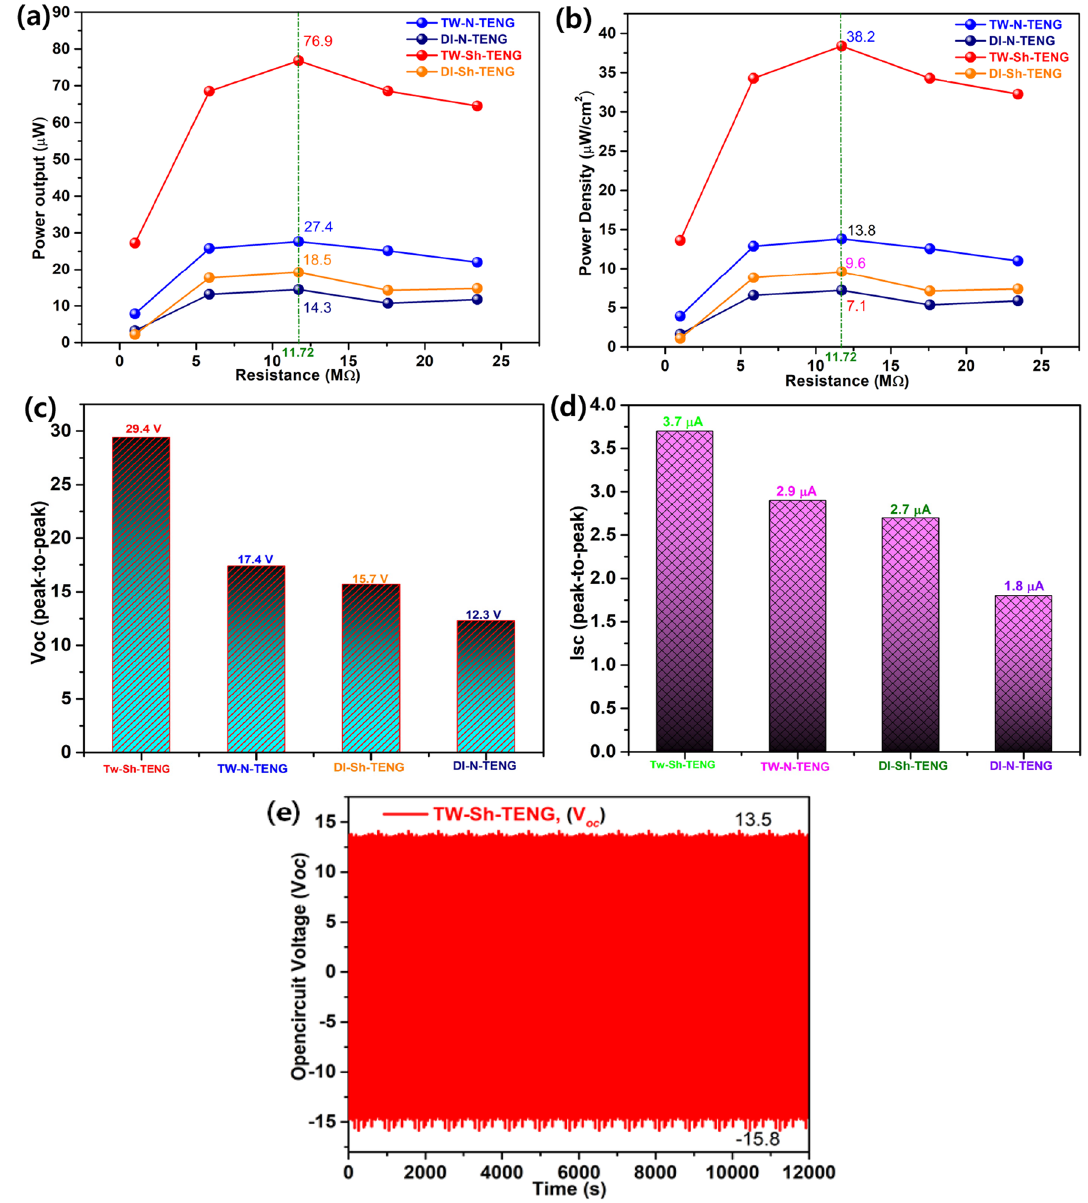
Figure 9. The power output ( a ); power density ( b ) and comparison of overall V oc ( c ) and I sc ( d ) of TW-Sh- TENG, TW-N-PTFE-TENG, DI-Sh-TENG and DI-N-TENG; ( e ) stability and durability test for 12,000 s were also conducted to confirm the durability and